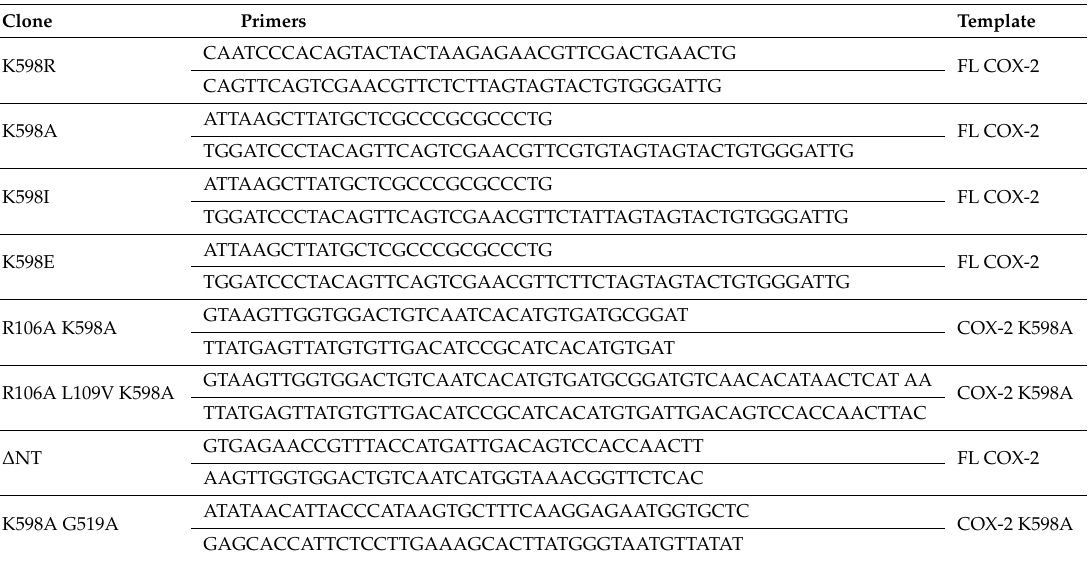
Table 1. Primers used for